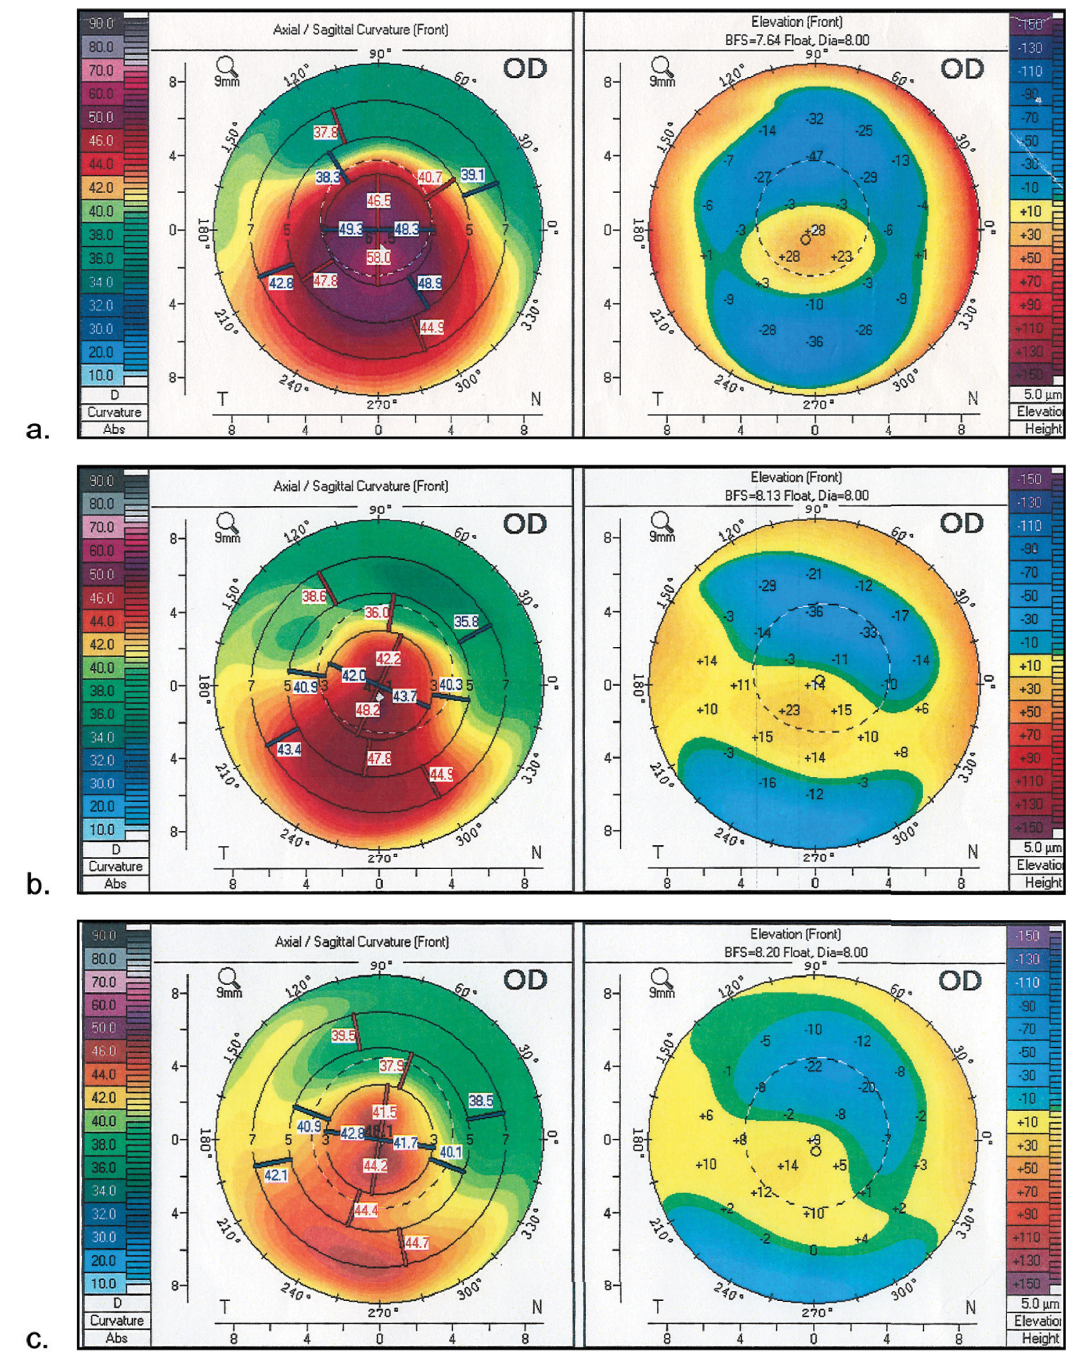
Fig 2. Pentacam sagittal curvature (front) and elevation (front) maps in patient from ICRS+TG-PRK group: a. initial keratometric maps; b. keratometric maps after ICRS; c. keratometric maps after ICRS+TG-PRK. ICRS = intrastromal corneal ring segments; TG-PRK = topography-guided photorefractive